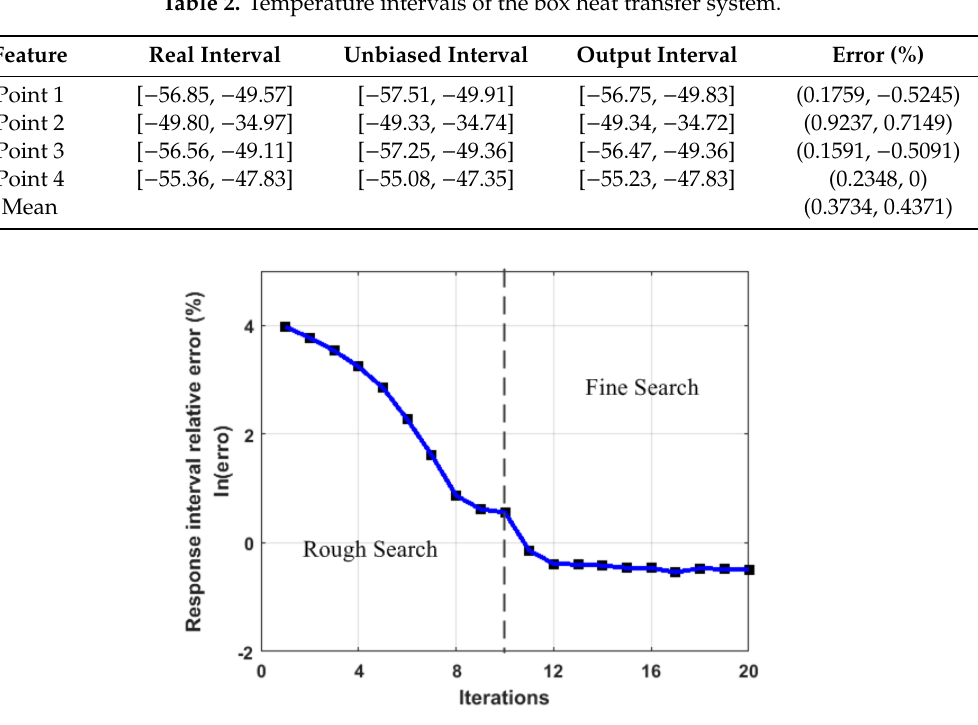
Figure 9. Convergence processes of temperature response relative error in the heat transfer system.